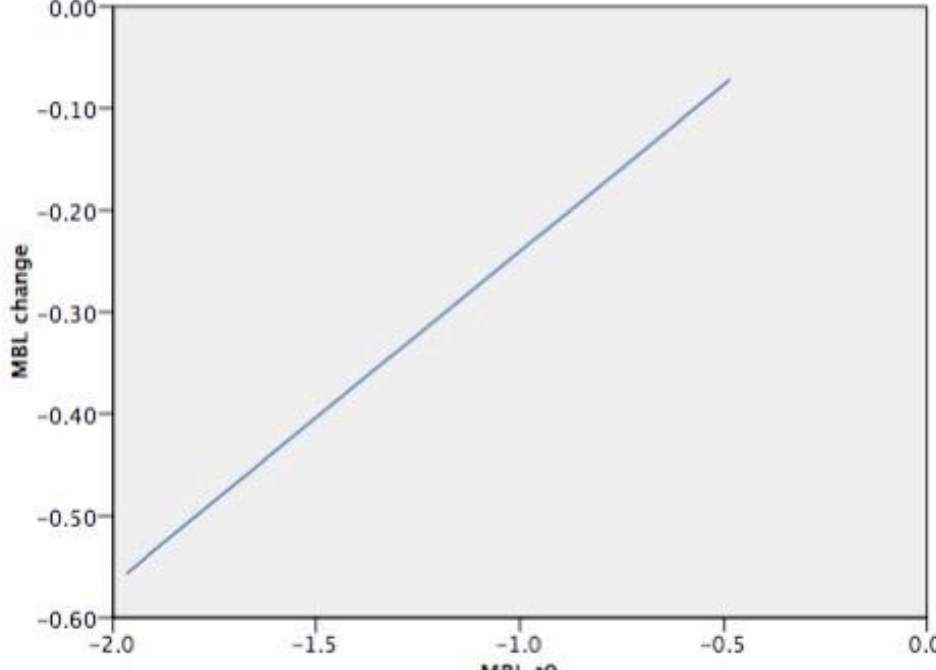
Figure 4. Estimated average MBL change according to MBL (t 0 ). Results are in mm. Table 8. Estimated MBL change (mm) according to years of follow-up and presence of diabetes.